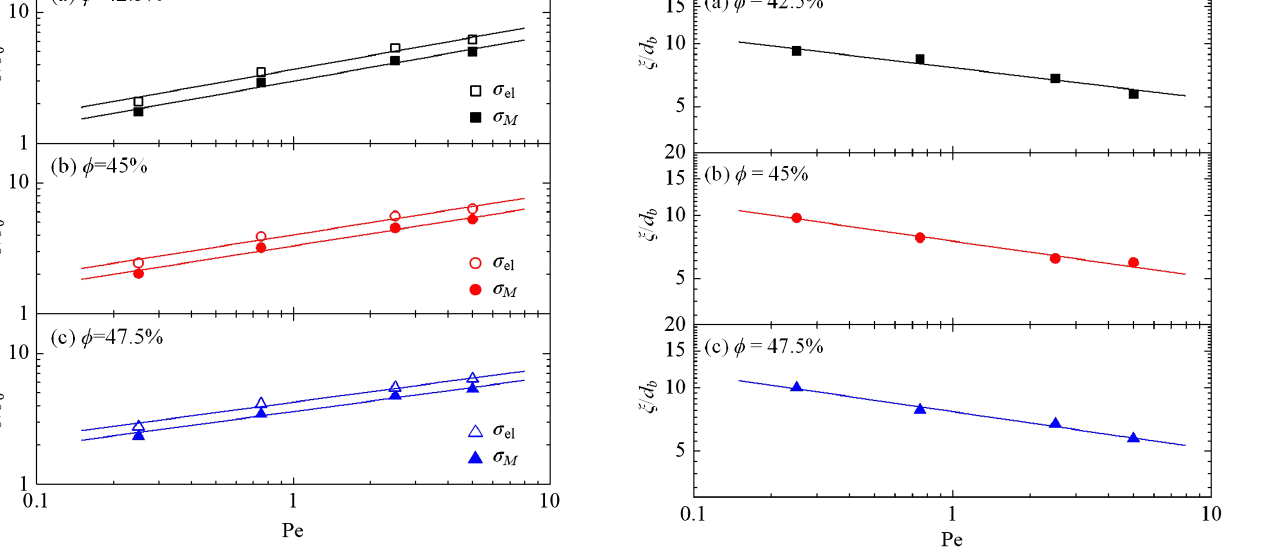
FIG. 3. The shear stress σ microscopic elastic stress σ shear-thinning regime. Lines denote the fits with the power law σ ∝ Pe ϵ . The stress is in units of σ the stress can be expressed as σ = σ 0 ¼ Pe · ð η = η